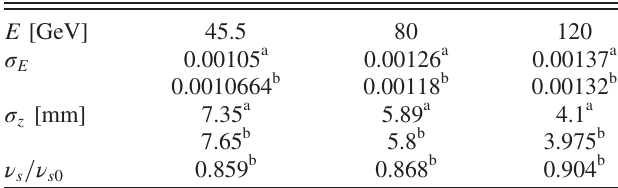
TABLE III. The CEPC beam energy spread and length as well as the synchrotron tune in arbitrary units due to the combined effect of SR, BS, and PWD.